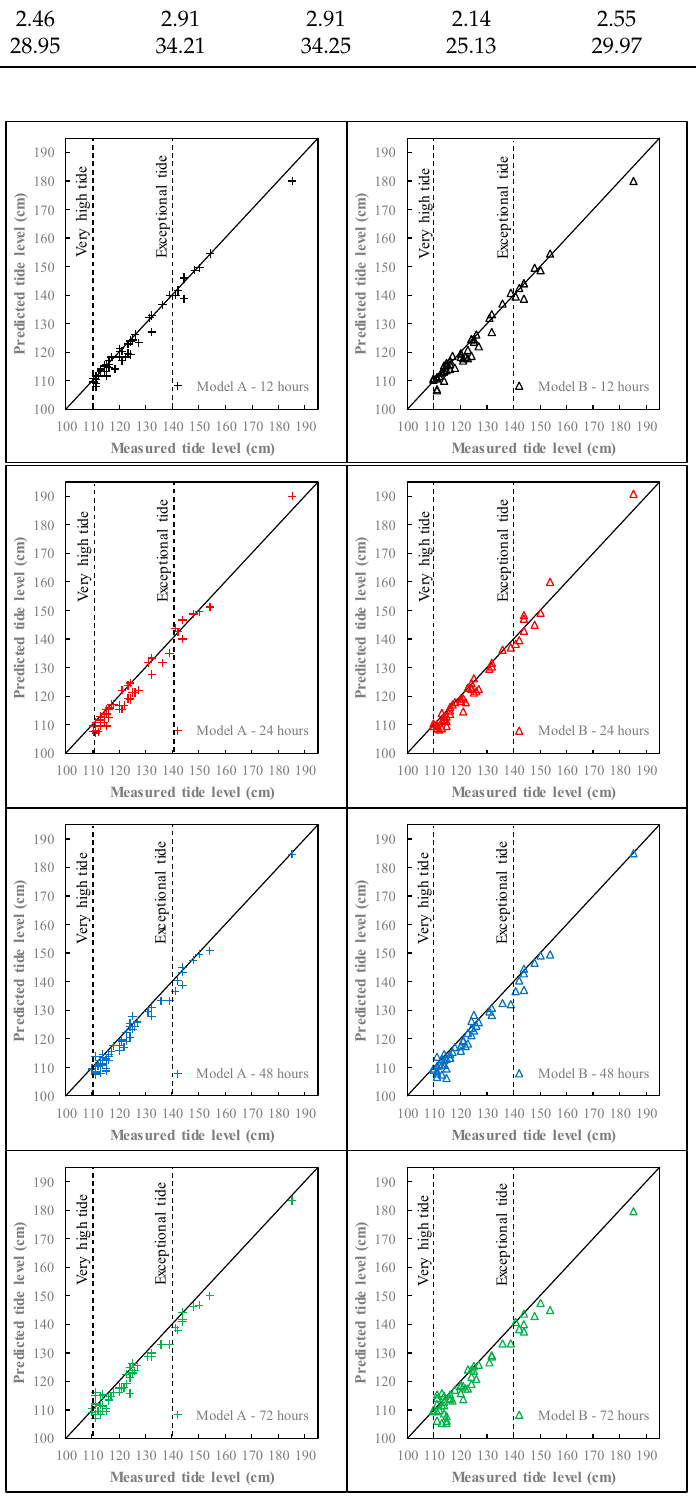
Figure 3. Comparison between measured and predicted storm tide.